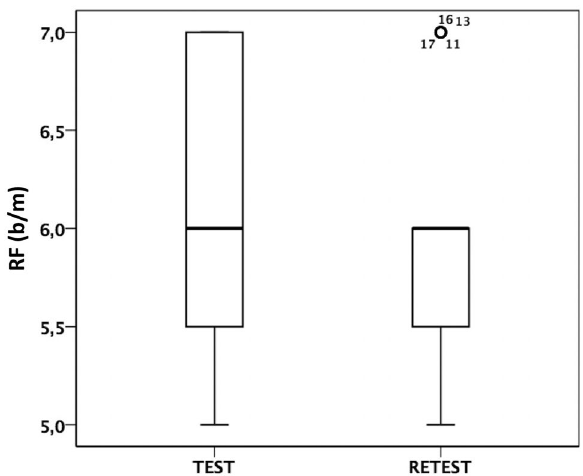
Figure 2. Comparative box plots of RF individual values (breaths per minute) at Test and